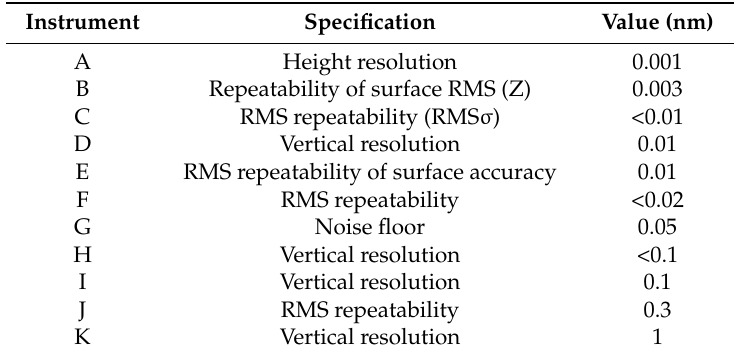
Table 1. Published specifications related to the concept of vertical resolution for a selection of commercially manufactured 3D interference